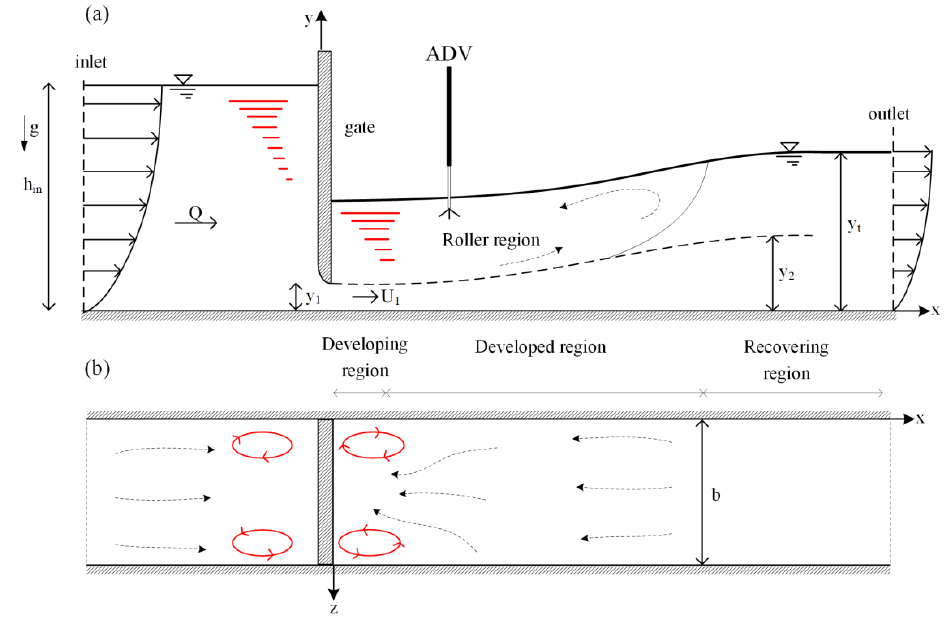
Figure 1. Sketch of the turbulent flow through a submerged vertical gate: ( a ) lateral view; ( b ) top view. The flow around the gate is three-dimensional and unsteady due to the interaction of the vortices with the mean flow, which produces counter-rotating vortices at the upstream and forms a roller region at the downstream of the gate (Figure 1). The reverse flow in the roller region interacts with the vortex-induced flow and creates two counter-rotating vortices downstream of the gate (Figure 1b). Several researchers conducted experimental studies in an attempt to evaluate the vortex-induced hydrodynamic pressures acting on the gate. Bhargava et al. [7] conducted experimental studies in a laboratory flume to investigate the hydrodynamic pressures on the gate lip in terms of mean and fluctuating pressure coefficients. Thang and Naudascher [8] studied the vortex-excited vibration of underflow lift gates experimental. They observed that the dynamic interaction between the gate and unstable shear layer may produce periodic vortex shedding that oscillates the gate. Turbulent flow- induced multiple mode vibration of the submerged gate was experimentally investigated by Billeter and Staubli [9] based on simultaneous measurements of velocity and pressure. Transition to galloping flow structure was found to play a significant role in the production of instability-induced